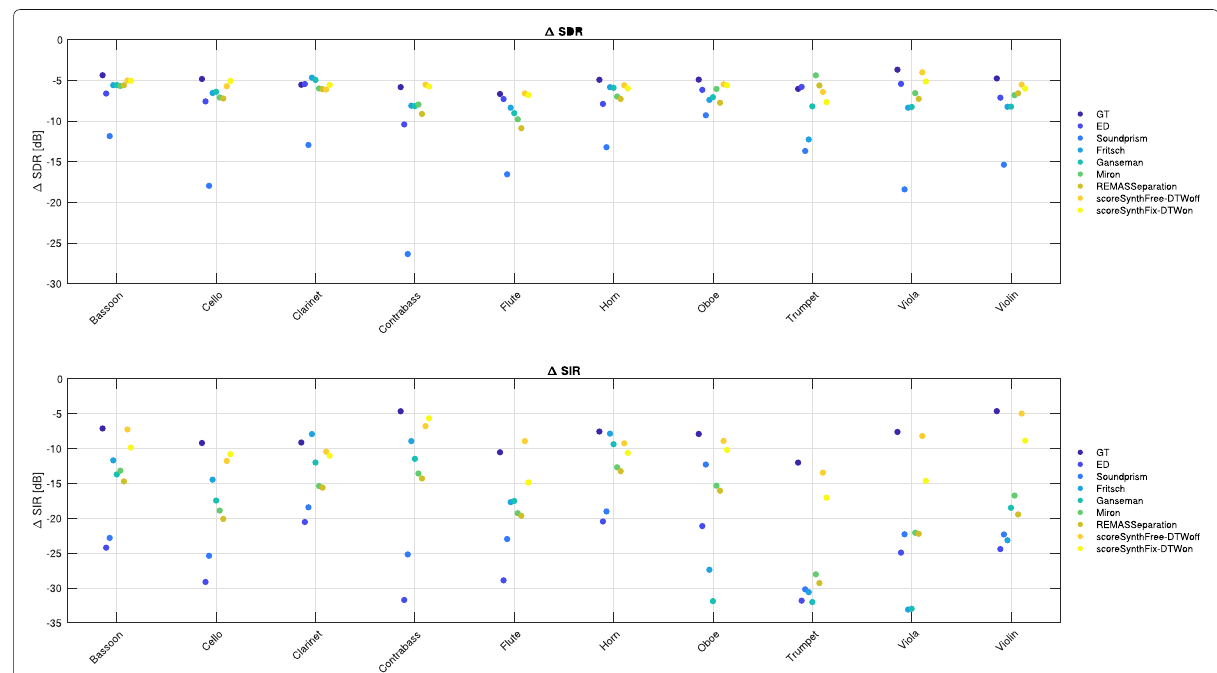
Fig. 9 Overall (cid:10) SDR and (cid:10) SIR results per instrument over the orchestra dataset for the methods presented in Section 5.4